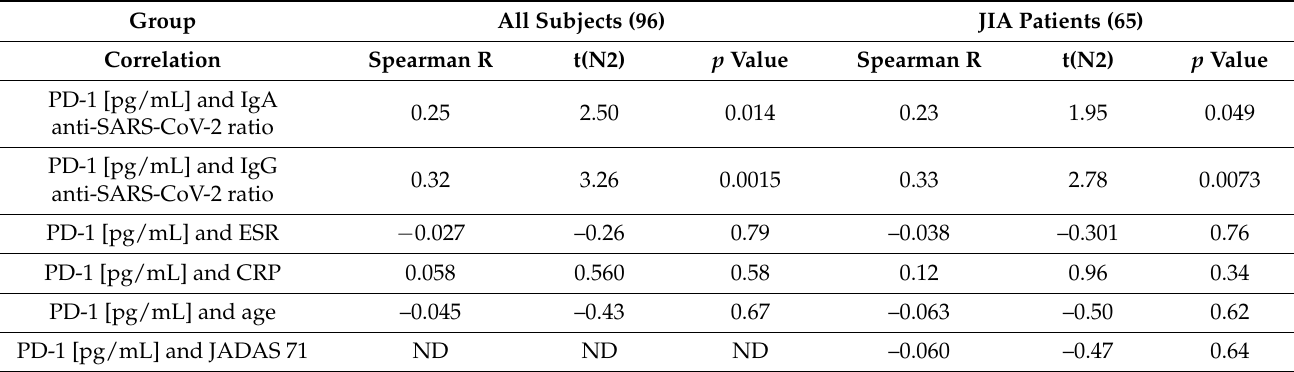
Table 4. Correlations (Spearman) for all subjects ( n = 96).